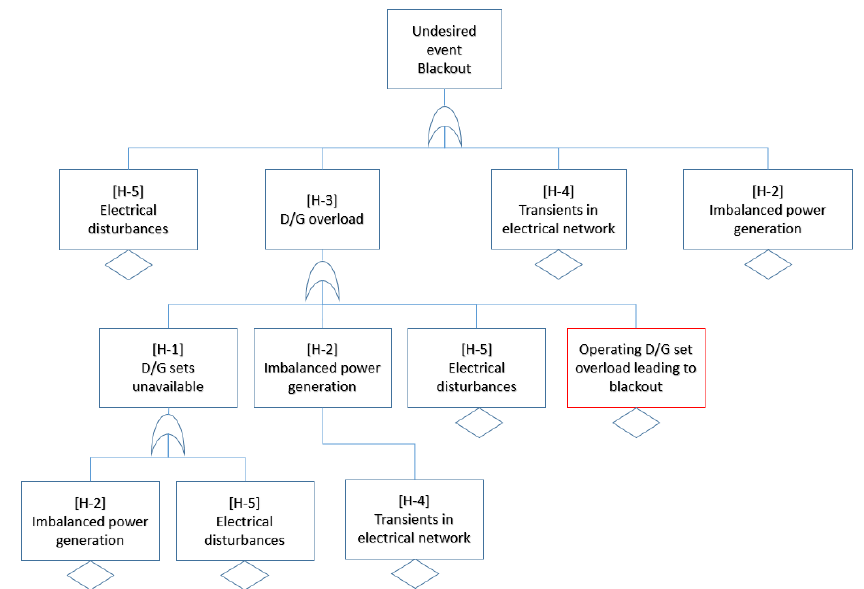
Figure 7. Result of synthesis of Event Trees.